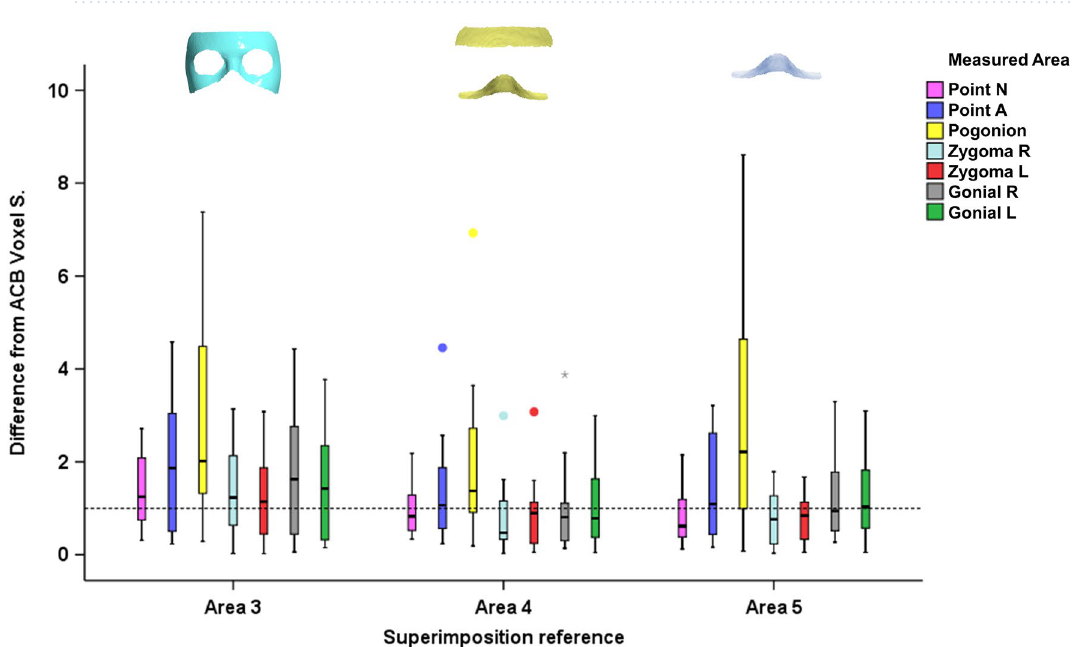
Figure 5. Box plots showing in the y-axis the difference of the ACB voxel from the surface based superimposition techniques. The upper limit of the black line represents the maximum value, the lower limit the minimum value, the box the interquartile range, and the horizontal black line the median value. The dashed horizontal line indicates difference of 1 mm. Zero value indicates perfect agreement with the gold standard. Outliers are shown as circles or asterisks, in more extreme cases, with a step of 1.5 × IQR (interquartile range). The vertical length of each plot indicates the variation of the